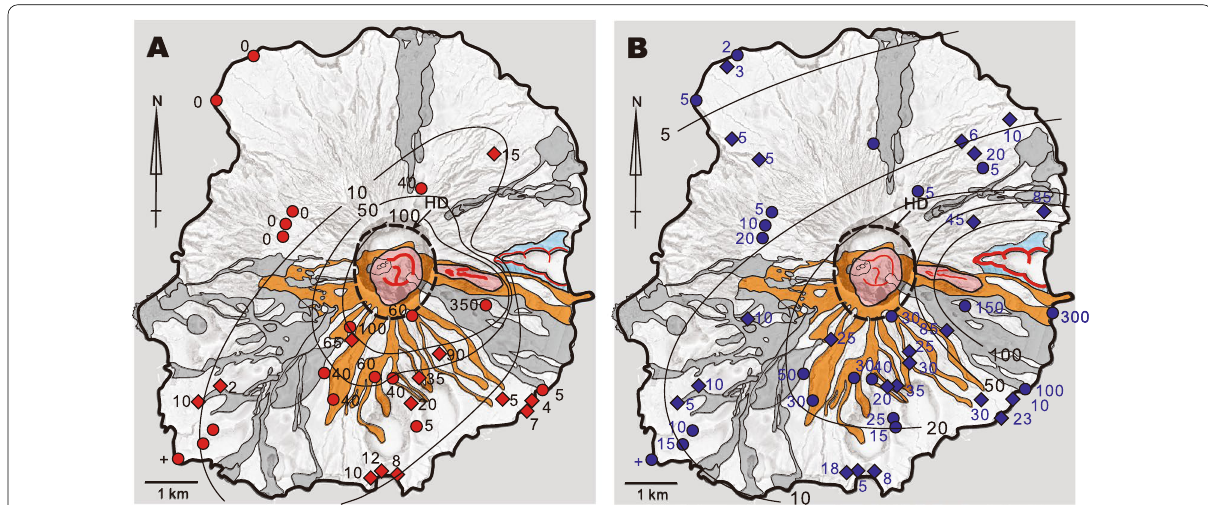
Fig. 7 Distributions of the Oyama scoria fall deposit ( A ) and Miike explosion breccia and associated PDC and ash-fall deposit ( B ) produced during the Oyama eruption. Orange area shows the distribution of the Oyama lava. Gray areas show the distribution of the deposits younger than the Oyama eruption. Circle symbols show the thickness data of these deposits by our field survey, and diamond symbols show the data after Tsukui and Suzuki